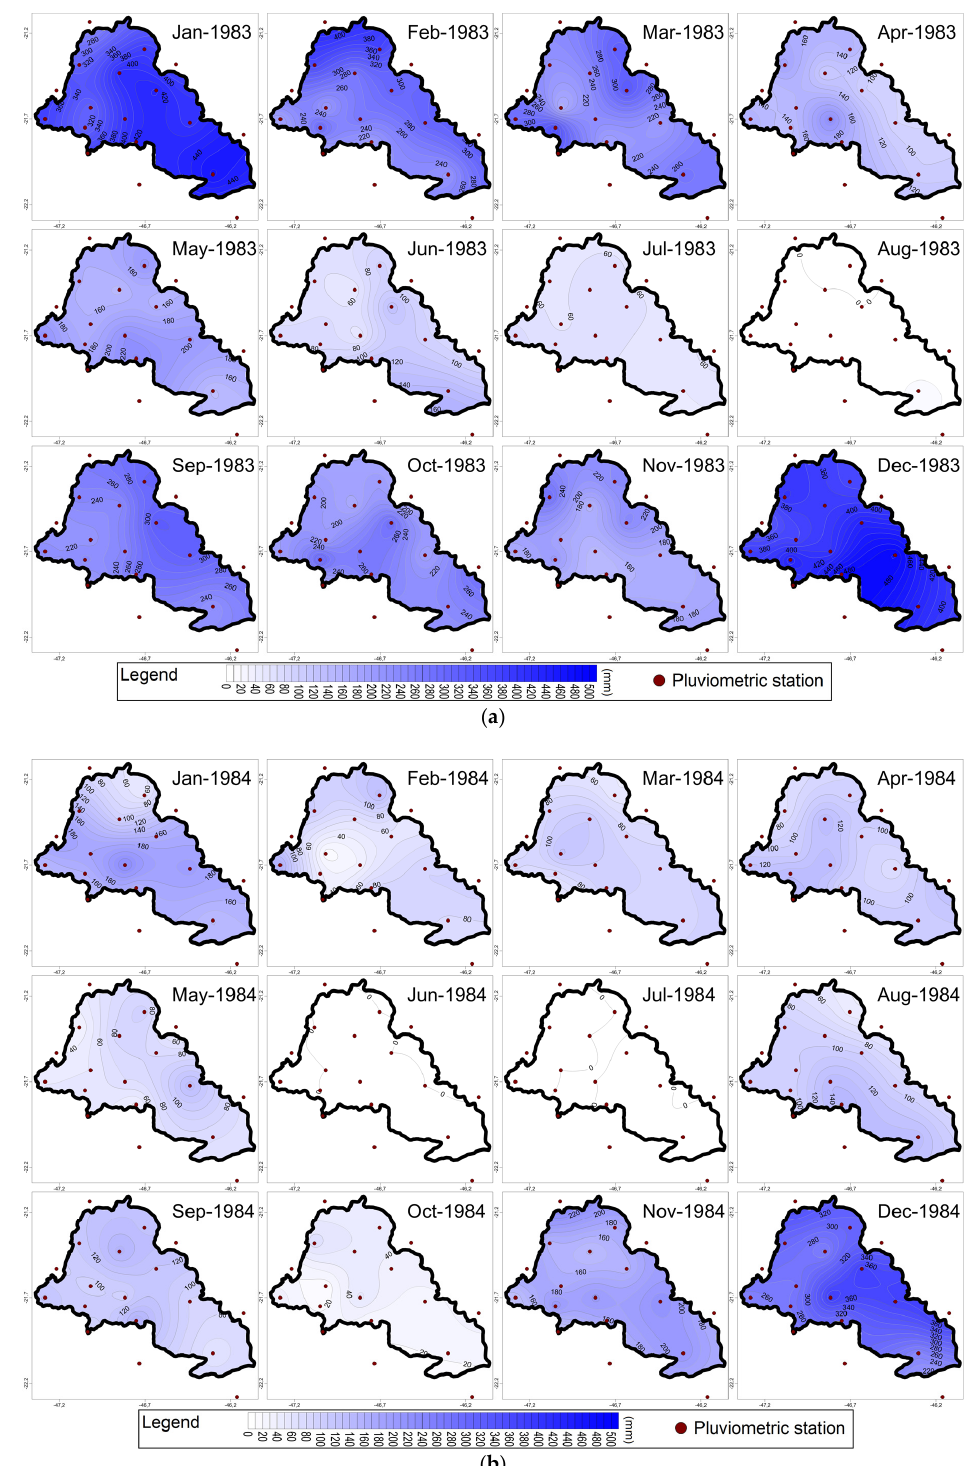
Figure 6. Distribution of monthly rainfall in the Alto Pardo watershed in ( a ) 1983 year; ( b ) 1984 year.